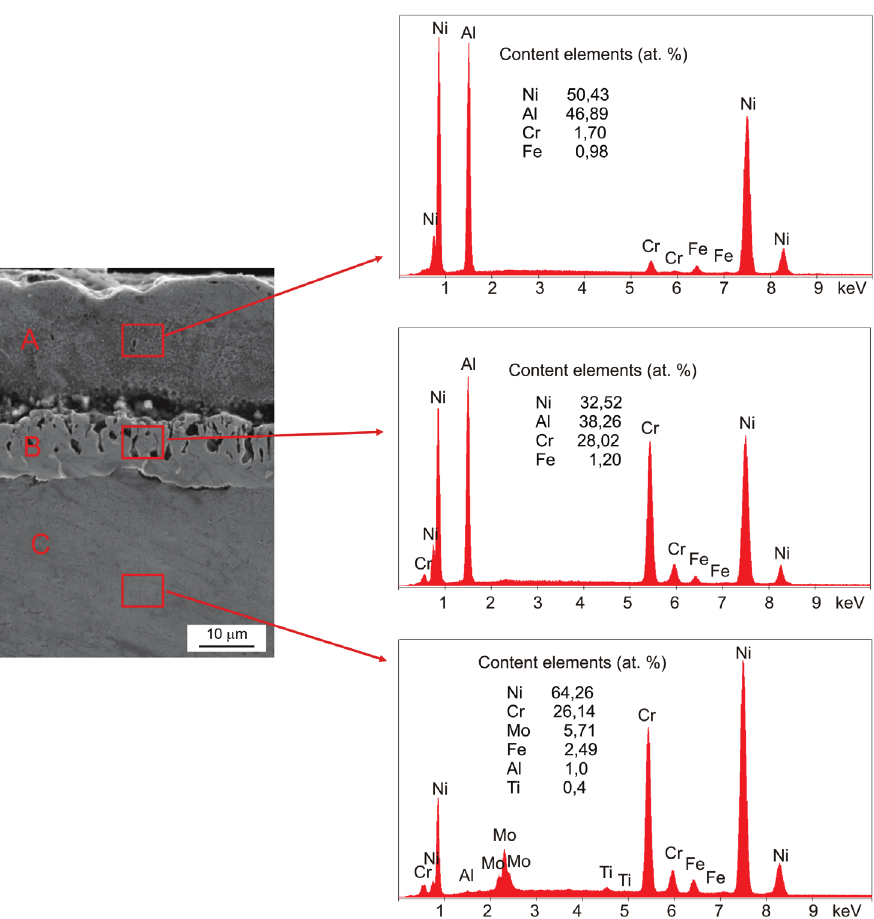
Figure 3: EDS spectrum analysis of a coating produced in the 4-h CVD process; A – outer zone, B – interior zone ( T ¼ 1,020 °C, t ¼ 4 h, p ¼ 150 hPa), C – substrate